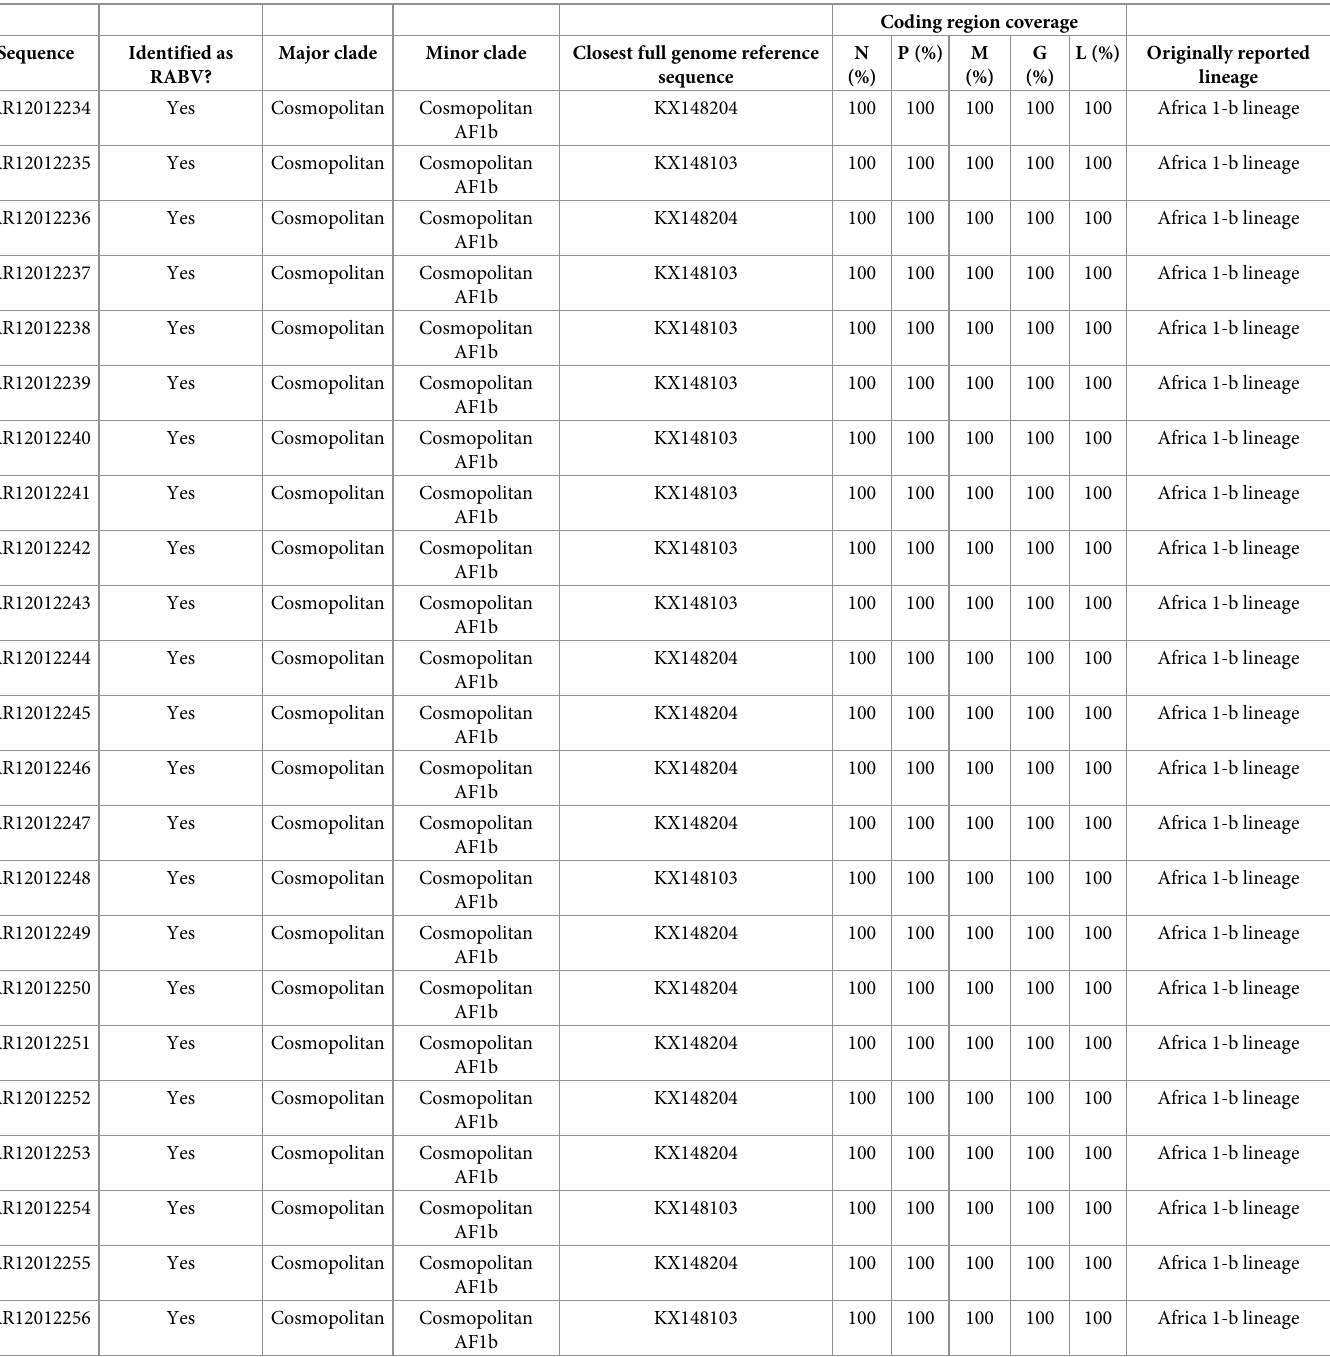
Table 5. Result of classification of the RABV datasets samples returned by RABV-GLUE.